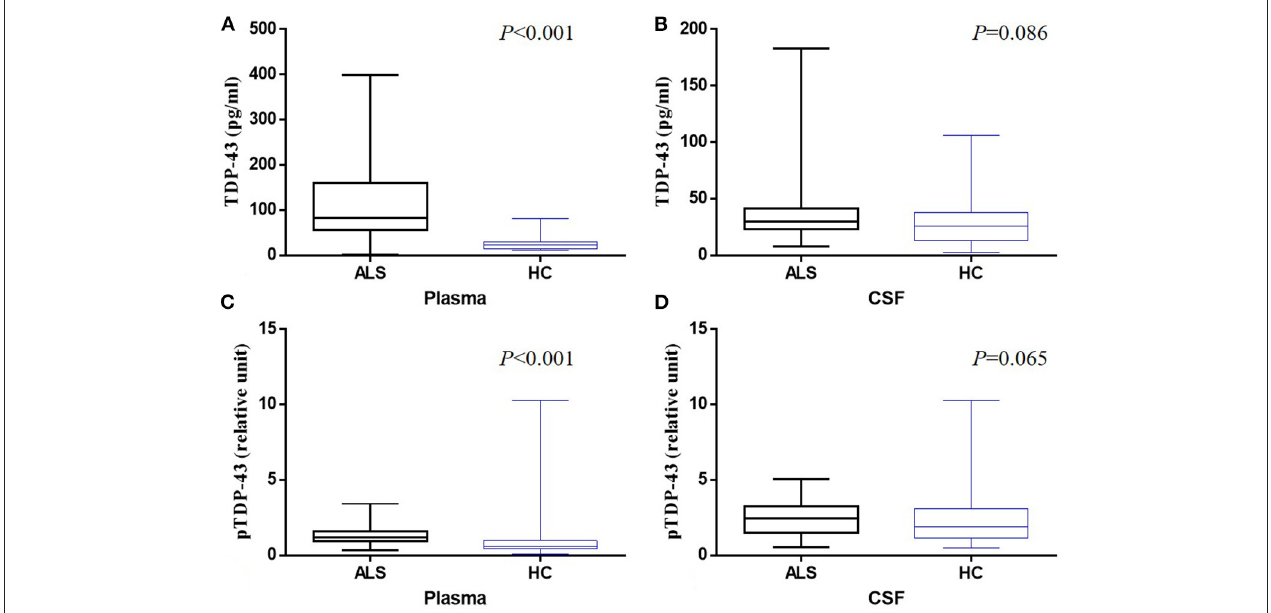
FIGURE 1 | Box-whisker plots illustrate concentrations of TDP-43 in plasma (A) and CSF (B) and pTDP-43 in plasma (C) and CSF (D) from ALS patients and healthy controls (HC). The horizontal line in the box represents the median. Bottom and top of the box represent the 25 th and 75 th percentile, respectively. The whiskers (error bars) represent the range.